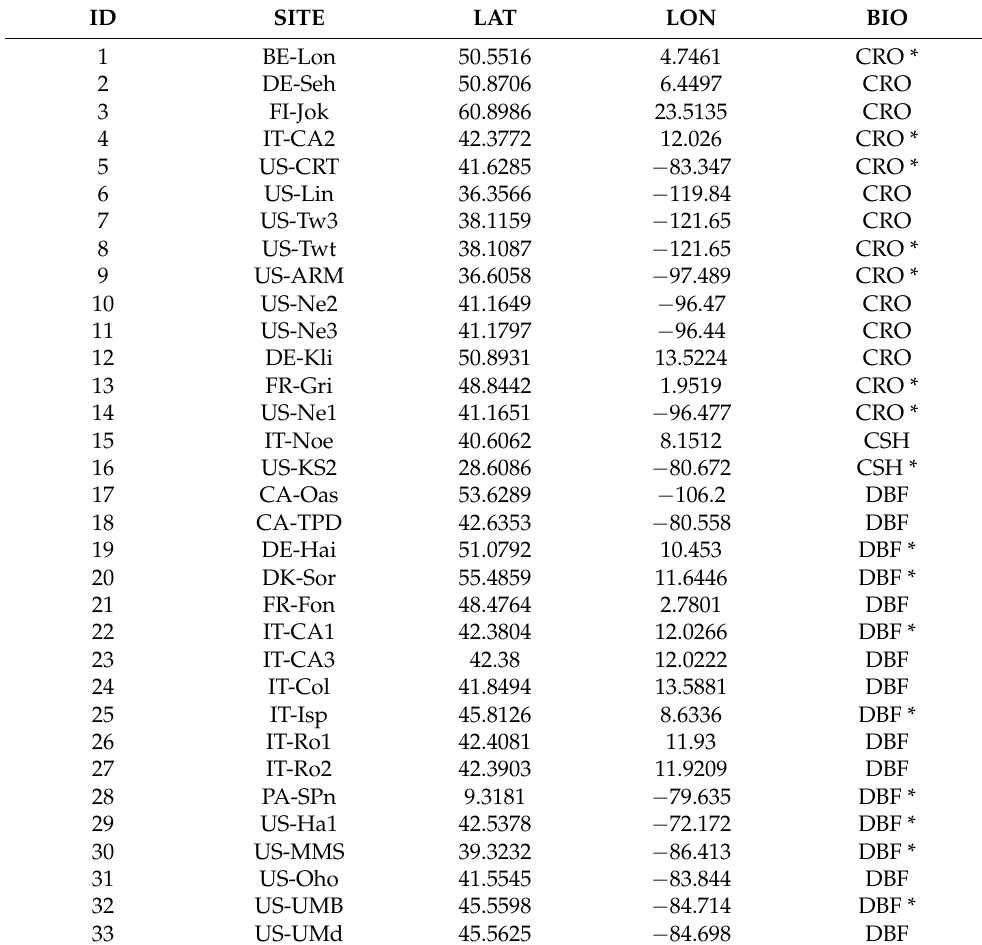
Table A1. Eddy covariance (EC) sites information used for research, including site id (ID), site name (SITE), latitude and longitude (LAT, LON), and biome type (BIO). The asterisk is used to verify the